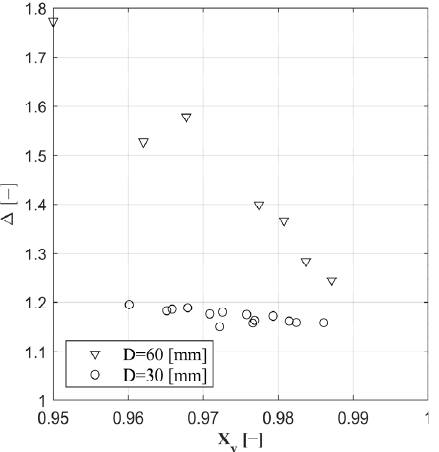
Figure 5. Δ vs. volume quality for the two pipelines tested. Figure 5. ∆ vs. volume quality for the two pipelines tested.